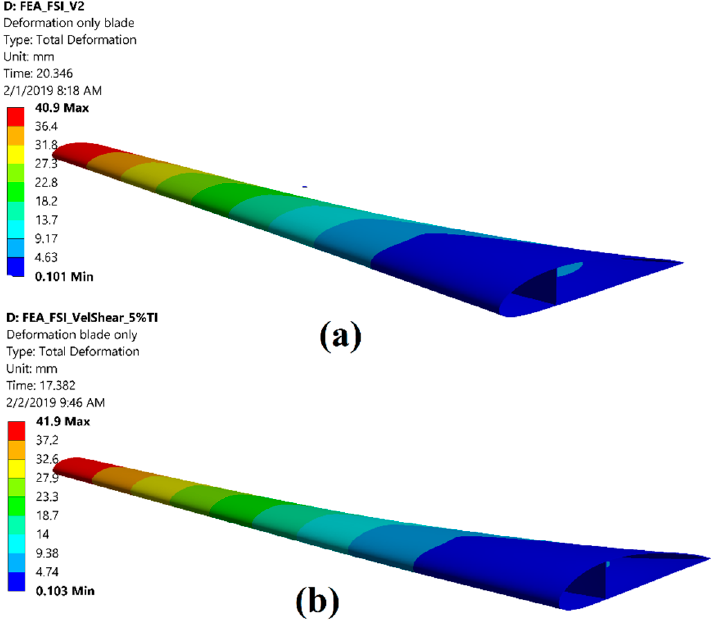
Figure 13. Contour plot of blade deformation for ( a ) uniform velocity; ( b ) velocity profile.